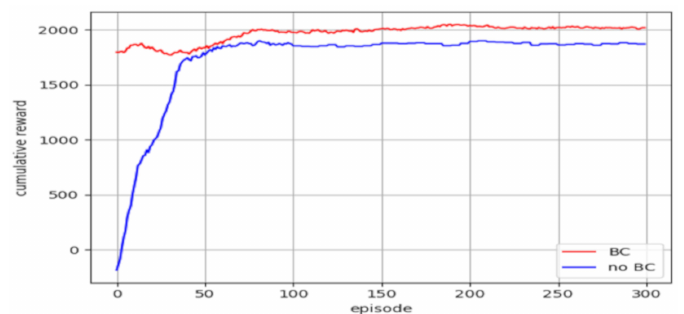
Figure 9. Comparison between training with behavior cloning and without.